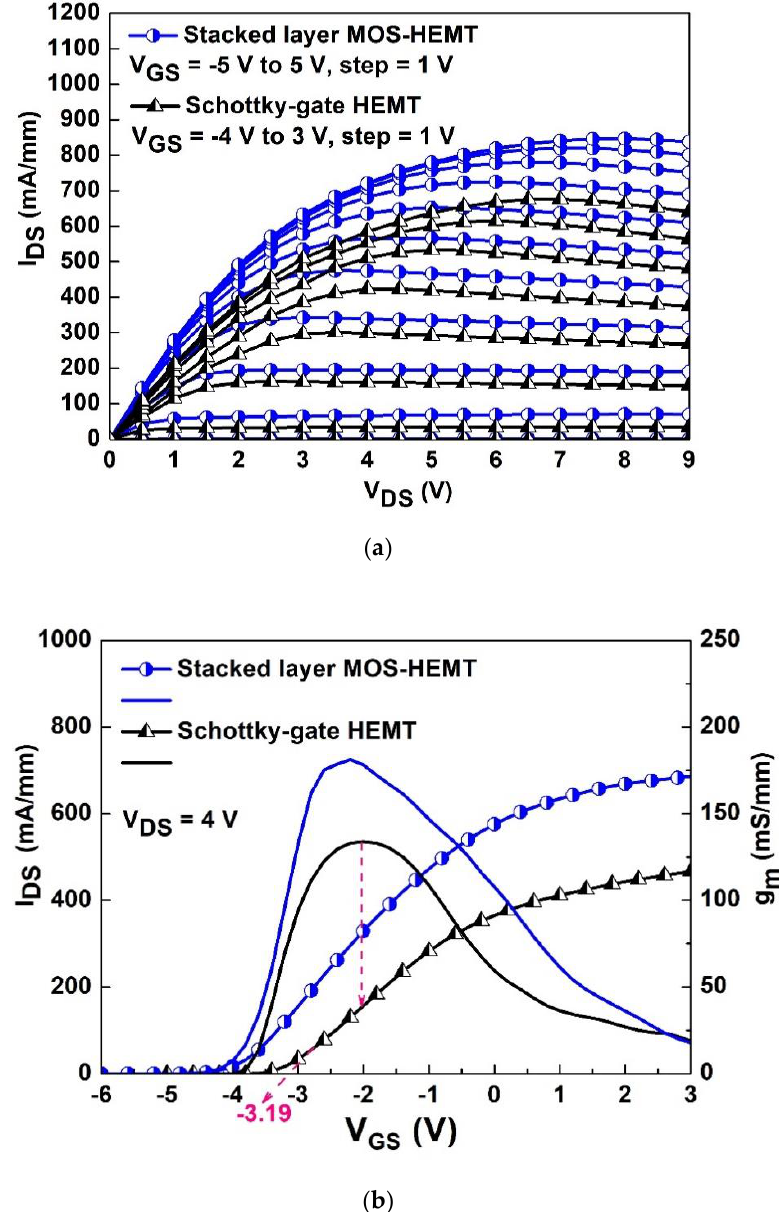
Figure 2. ( a ) I DS -V DS characteristics and ( b ) corresponding g m and I DS versus V GS at 4 V of V DS for both devices.